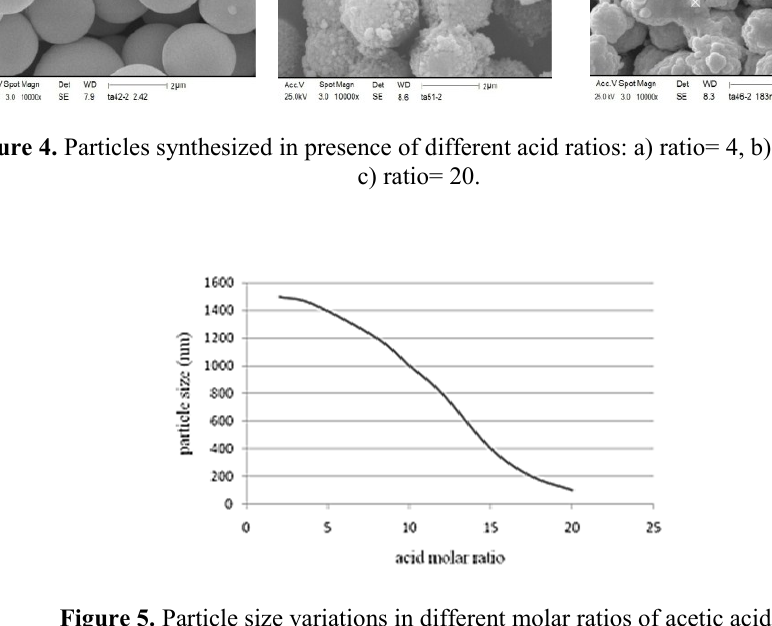
Figure 5. Particle size variations in different molar ratios of acetic acid.